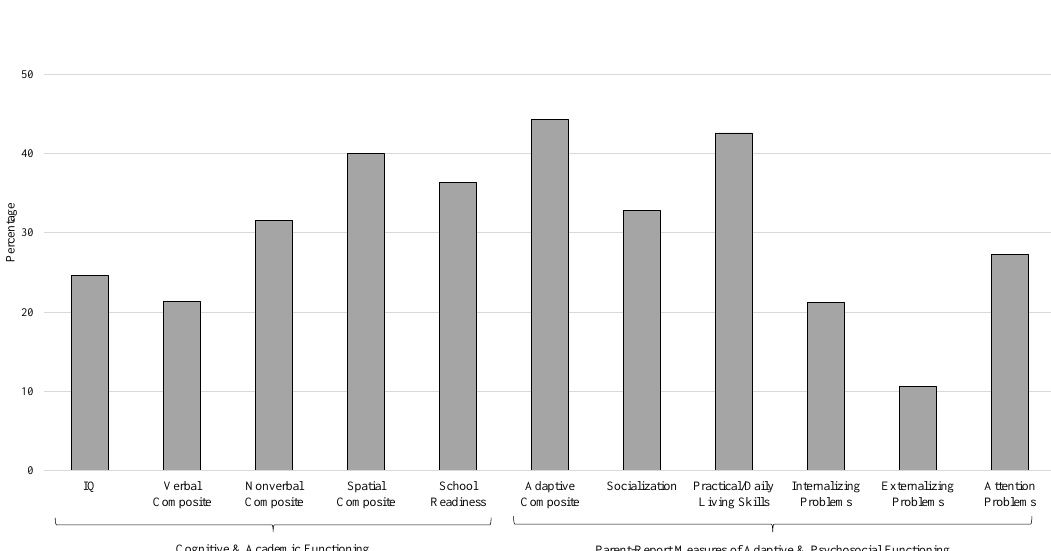
Figure 1. Percentage of sample administered an objective measure of cognitive or pre-academic functioning (n = 65), a parent-reported measure of adaptive (n = 70), or psychosocial functioning (n = 66) that fell within the impaired range (cognitive / academic, adaptive: Standard Score < 80; psychosocial: T-score ≥ 64).